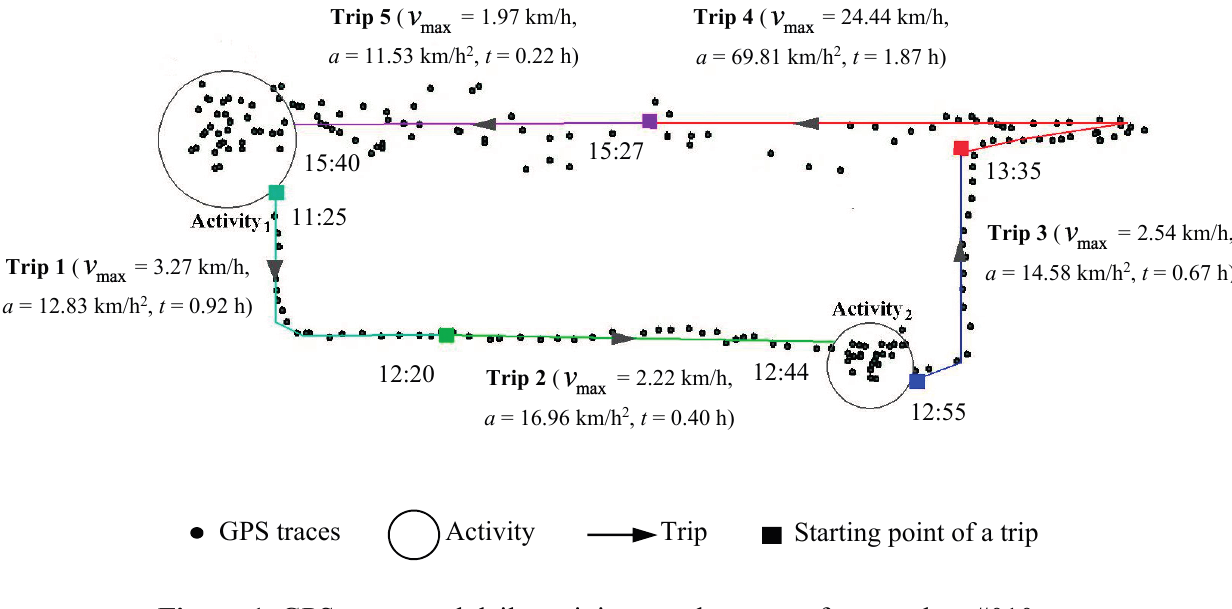
Figure 1. GPS traces and daily activity travel pattern of respondent